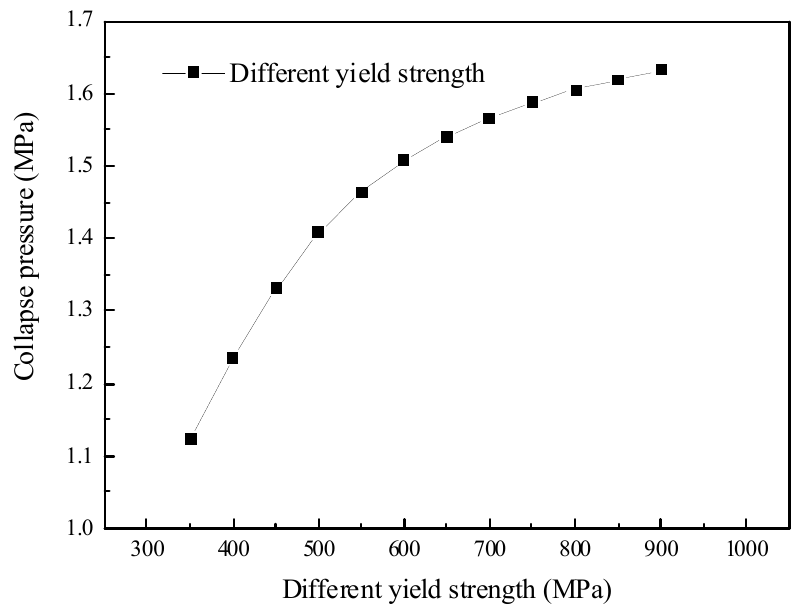
Figure 12. Collapse pressure with different yield strength.